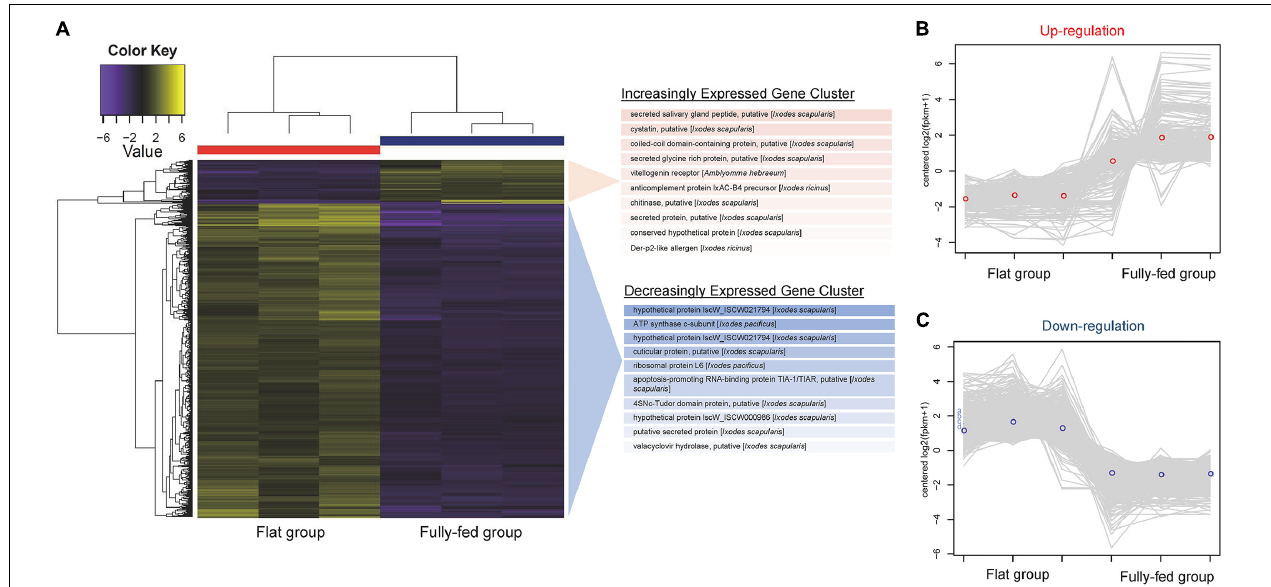
FIGURE 4 | RNAseq analysis of tick gene transcripts detected in pools of flat and fully fed I. persulcatus ticks removed from human patients at Mudanjiang Forestry Central Hospital in Heilongjiang Province, China. (A) Clustered heatmap of genes differentially expressed (DE) between flat and fully fed ticks. The top 10 most significant genes in the increasing and decreasing expression clusters are shown. The expression patterns of DE genes in each tick pool are shown for (B) upregulated genes and (C) downregulated